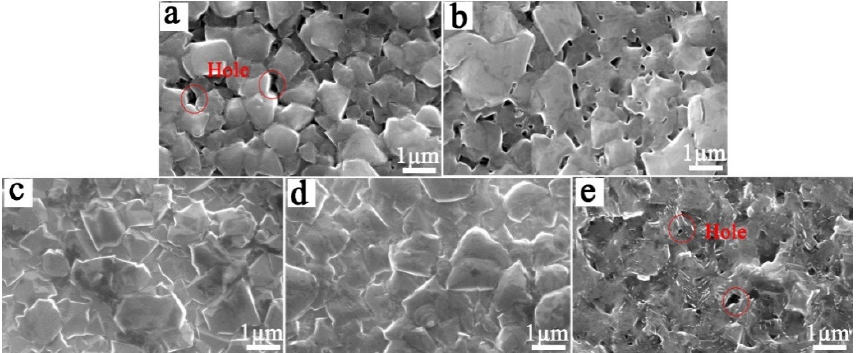
Figure 10. The morphology of the BDD coating of two samples after electrolysis of different times in 276